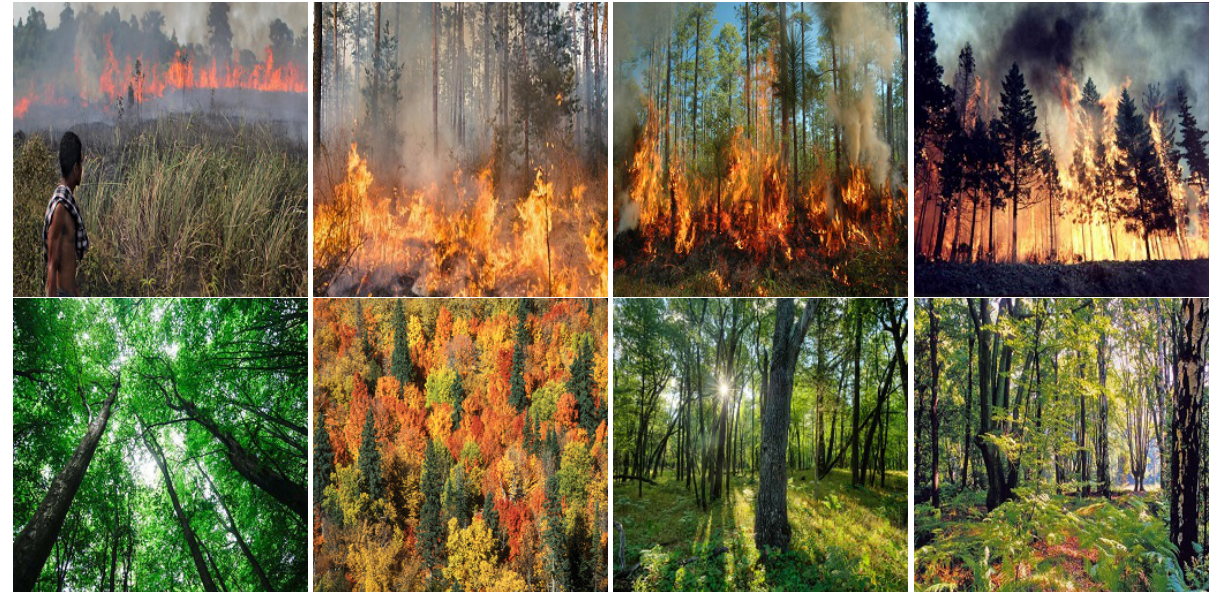
Figure 16. FIRE dataset example. ( Top ): Fire images; ( Bottom ): non-fire images.